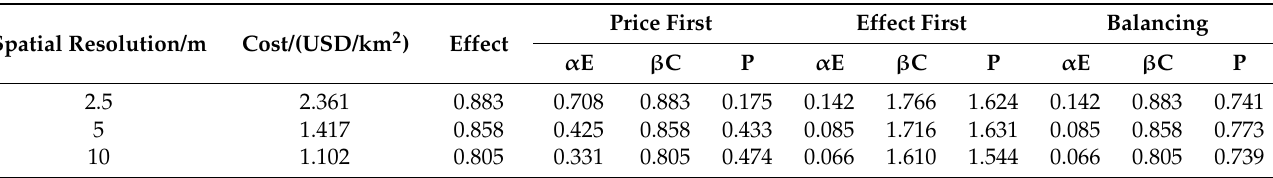
Table 3. Cost-effectiveness evaluation under different scenarios, where α and β are weight parameters, C is the cost, E is the effectiveness, and P is the comprehensive